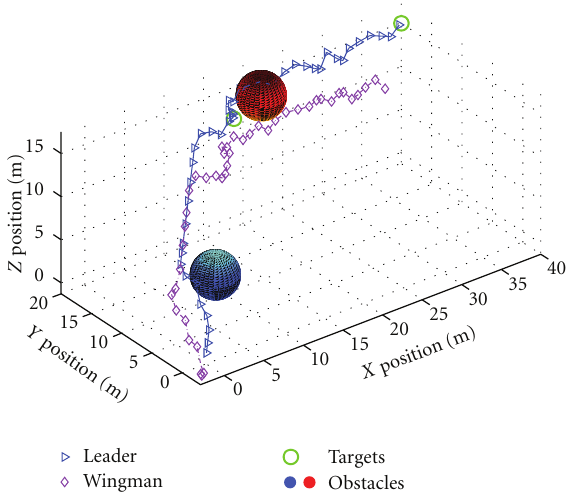
Figure 12: 3D Formation